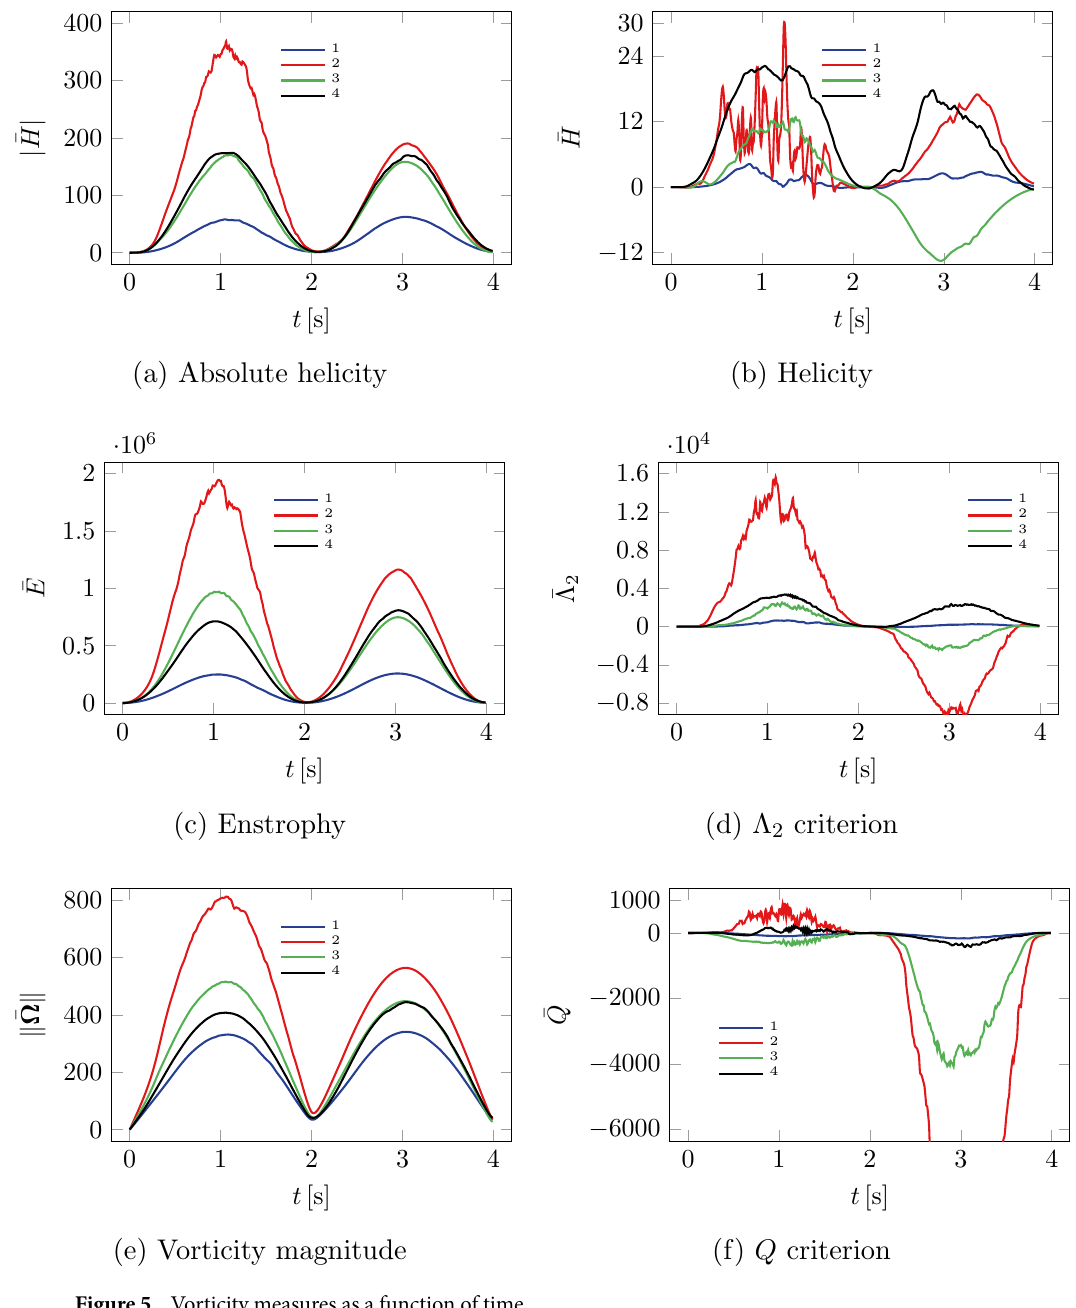
Figure 5. Vorticity measures as a function of